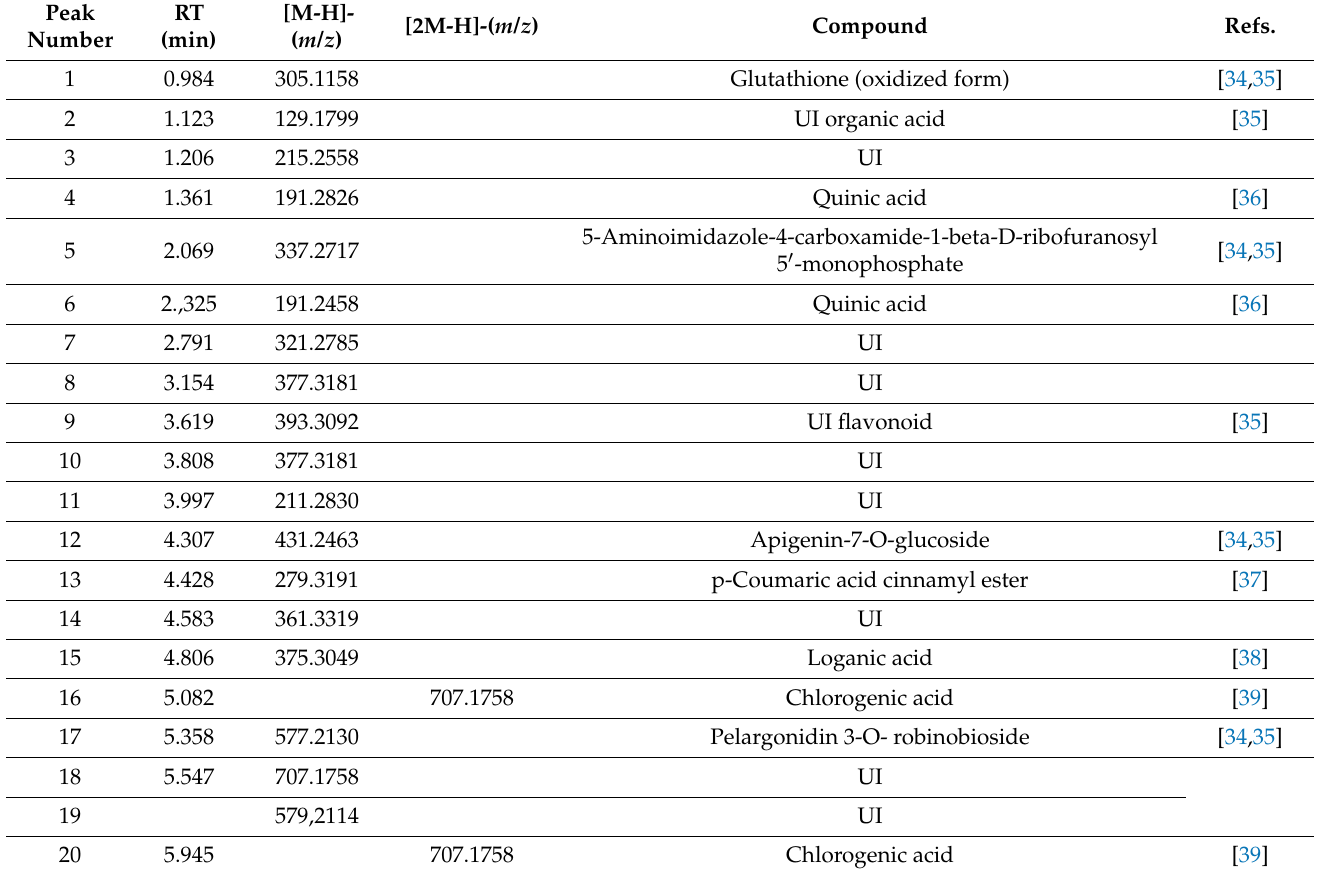
Table 3. The phenolic compounds identified in guelder rose